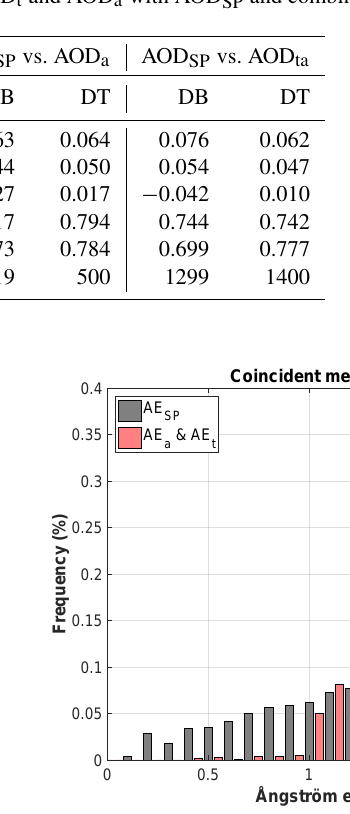
Table 5. Statistics from comparing collocated single observation of AOD t and AOD a with AOD SP and combined AOD ta .